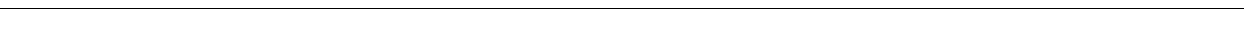
Figure 7 | The KDM3A–KLF2–IRF4 axis contributes to adhesion and homing of MM cells to the bone marrow. ( a ) RPMI8226, MM.1S and U266 cells expressing each shRNA were labelled with calcein-AM and incubated in bone marrow stromal cells (BMSC)- or fibronectin (FN)-coated plates. After washing plates, adherent cells were quantified using a fluorescence plate reader. Results are shown as per cent adhesion over the input. BSA-coated wells were used as negative control. ( b ) MM.1S cells transduced with each shRNA were placed in the upper chamber of a modified Boyden chamber and incubated with CXCL12 (20nM) added to the lower chamber. After 4h, cells that migrated to the lower chamber were quantified. Results are shown as per cent migration over the input. ( c ) MM.1S-Luc-GFP cells expressing each shRNA (15 (cid:2) 10 6 viable cells) were intravenously injected into NOD-SCID mice. Twenty-four hours after injection, bone marrow cells of recipient mice were collected, and GFP-positive cells were detected using flow cytometry. Results are shown as homing efficacy relative to shRFP cells. Data represent mean ± s.e.m. n ¼ 4–5 mice per group. * P o 0.05, *** P o 0.001 compared with control; ANOVA followed by Dunnett’s test. ( d ) Immunoblot analysis of ITGB7 after knockdown of KDM3A , KLF2 , IRF4 in RPMI8226 and MM.1S cells. Shown are the relative signal intensity (shLuc ¼ 1) normalized by Actin. Error bars represent s.d. of two (RPMI8226) or three (MM.1S) independent experiments. ( e ) RPMI8226 cells expressing each cDNA were transduced with each shRNA as shown. Whole-cell lysates were subjected to immunoblot analysis. Data are representative of two independent experiments. ( f ) Adhesion assays were performed with RPMI8226 and MM.1S cells treated with either shITGB7 or shLuc. ( g ) Model of the KDM3A–KLF2–IRF4 axis in MM cells. KDM3A demethylates H3K9 of KLF2 and IRF4 promoter, resulting in upregulation of KLF2 and IRF4 . KLF2 and IRF4 mutually activate expression of each other. The KDM3A–KLF2–IRF4 axis maintains MM cell survival and homing to the bone marrow. For a , b , f , data represent mean ± s.d. of quadruplicate incubations ( a , f ), or triplicate incubations ( b ). * P o 0.05, ** P o 0.01, *** P o 0.001 compared with control; Student’s t